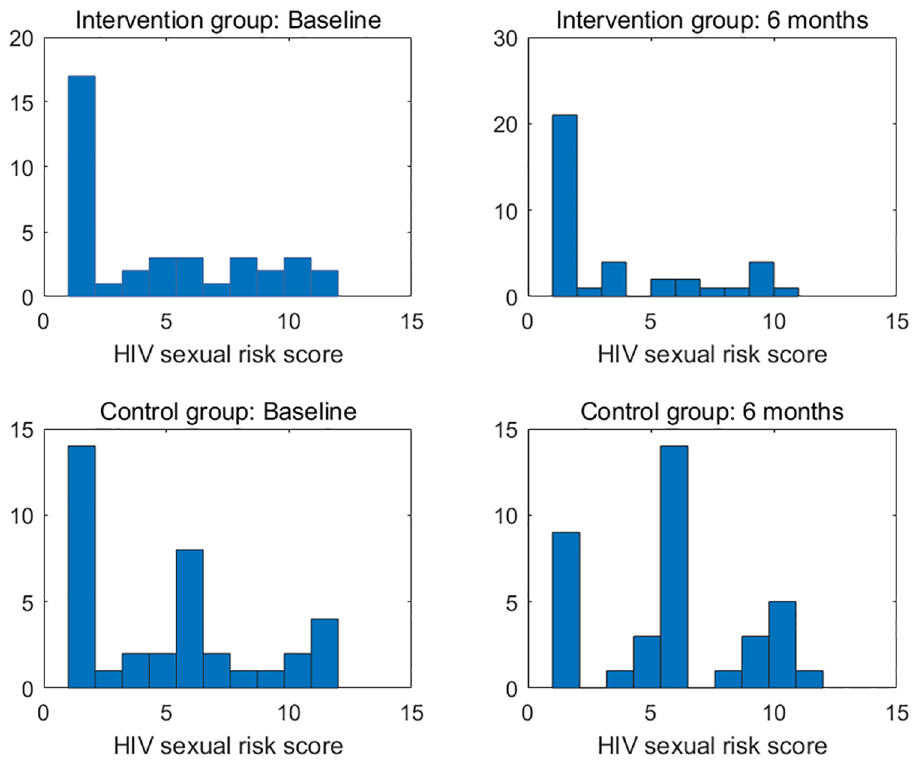
Fig 1. Histograms of HIV sexual risk scores for treatment and control groups at baseline and 6-month